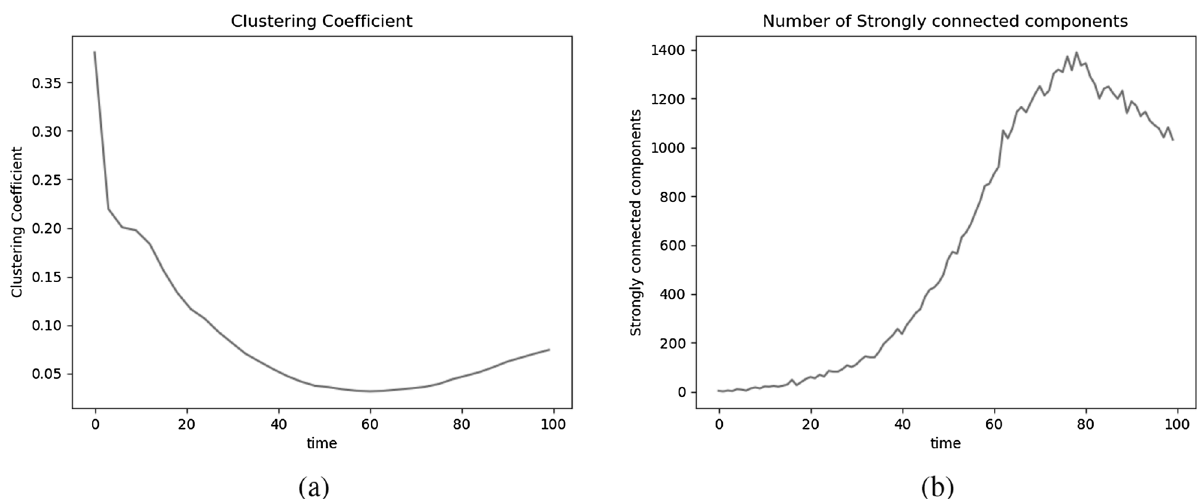
Figure 7. ( a ) clustering coefficient and ( b ) number of strongly connected components of directed networks generated using the selected model.